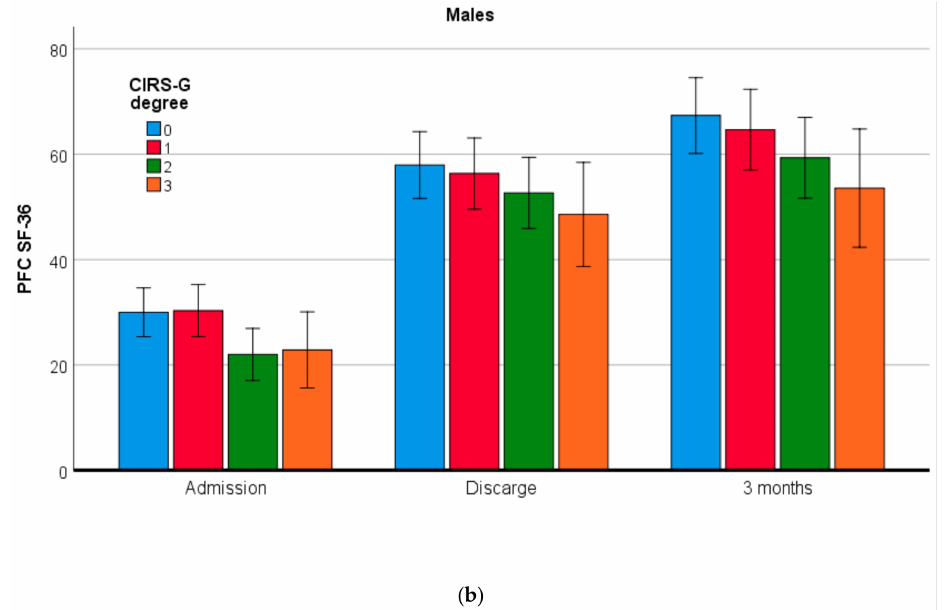
Figure 1. Mean values with 95% CI of physical functioning component (PFC) SF-36 for di ff erent CIRS-G degrees on three occasions in: ( a ) females; ( b ) males.